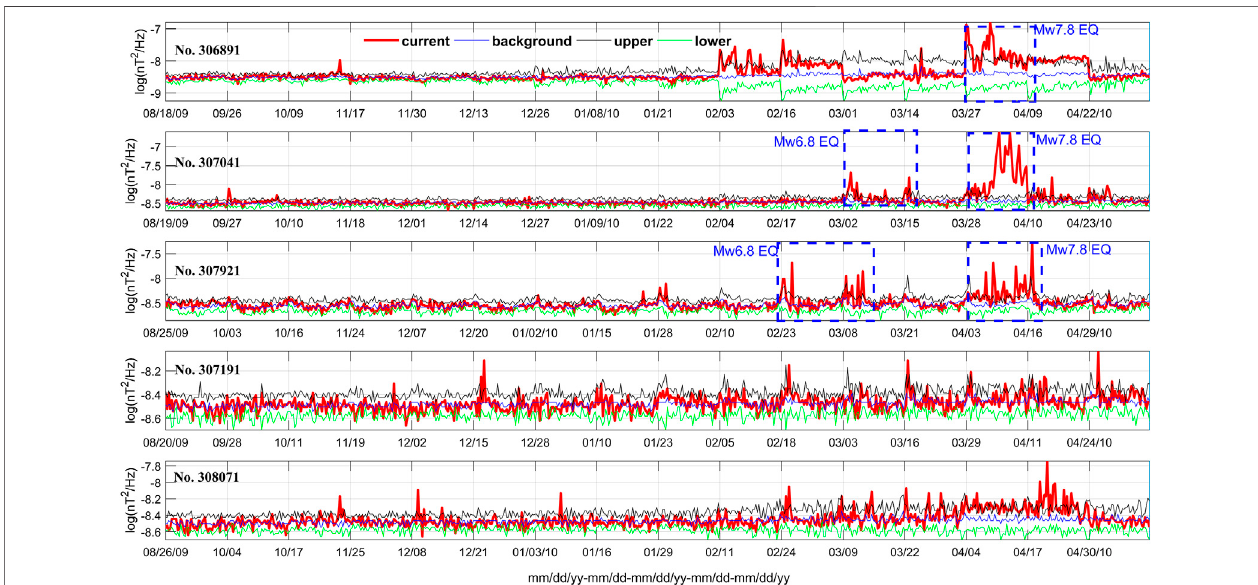
de fi ned the running median PSD values as the background trend (denoted by blue lines in Figure 4 ), while the median PSD values of the current orbit as the current variation level (represented by red lines). The upper and lower bound were computed by the